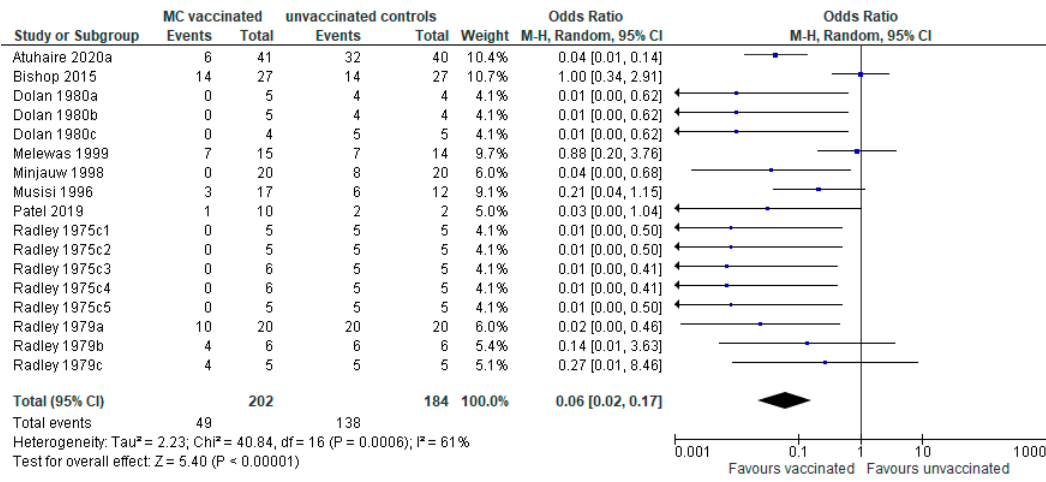
Figure 3. Forest plot showing comparison of severe reactions in MC vaccinated vs. nonvaccinated. The blue boxes represent the effect size (odds ratio) of each study—a bigger box indicates the study was weighted more, i.e., a larger sample size. The black diamond represents the pooled OR of the studies.